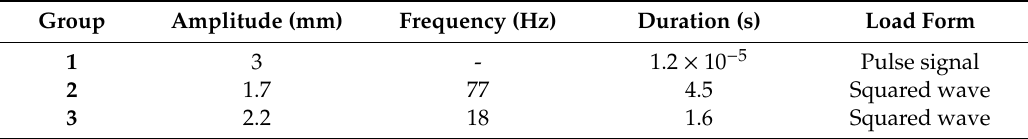
Figure 5. ( a ) Equivalent input estimation of the MEMS resonant accelerometer under dynamic condition with multi disturbances, ( b ) detail view of estimation results from − 4 mV to 4 mV, ( c ) adaptive window-length variance of the filter under dynamic condition. Table 4. Characteristic of multi disturbances in dynamic test.